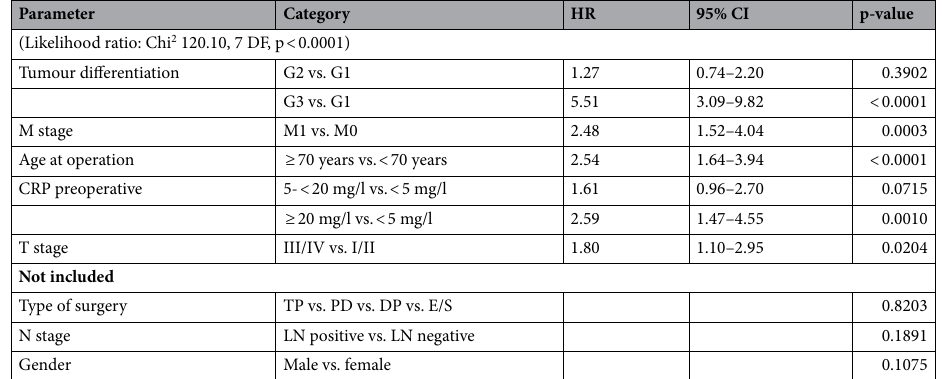
Table 5. Multivariable Cox regression analysis of parameters associated with overall survival in n = 395 non- functioning pancreatic neuroendocrine neoplasms after surgical treatment (n = 51 patients with missing values